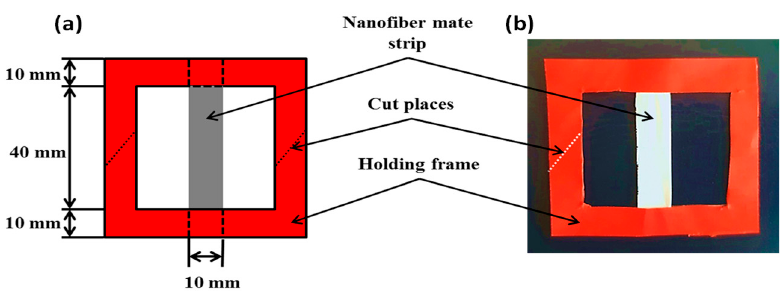
Figure 1. Mechanical test set-up. ( a ) Schematic diagram of the cardboard holding frame used for testing and ( b ) real view of the cardboard holding frame with test sample.